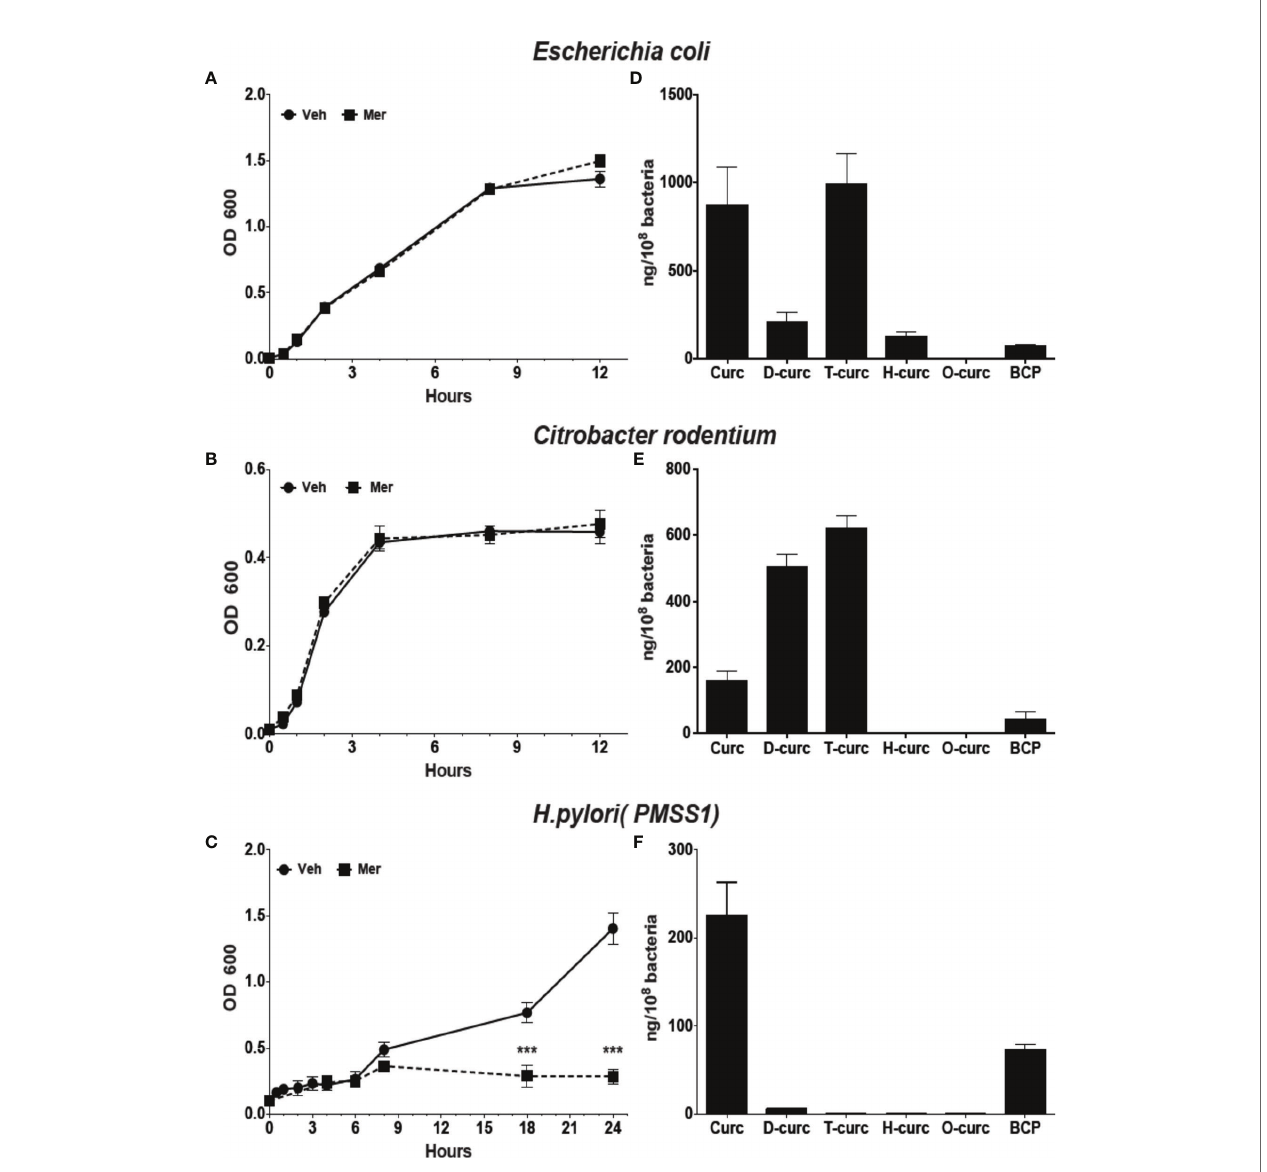
FIGURE 2 | Effect of Meriva on growth of E. coli , Citrobacter rodentium , and H. pylori , and intracellular accumulation of curcumin and its derivatives. (A – C) Bacteria were grown in Brucella broth containing 20 µM Meriva or vehicle (ethanol), and growth was monitored by optical density for indicated time. (D – F) Bacteria were harvested and the concentration of curcumin, dihydro-(D-curc,DHC)-, tetrahydro-( T-curc-THC)-, hexahydro-(H-curc,HHC)- and octahydro-(O curc,OHC)-curcumin as well as bicyclopentadione (BCP) was quanti fi ed using LC-MS. ***P ≤